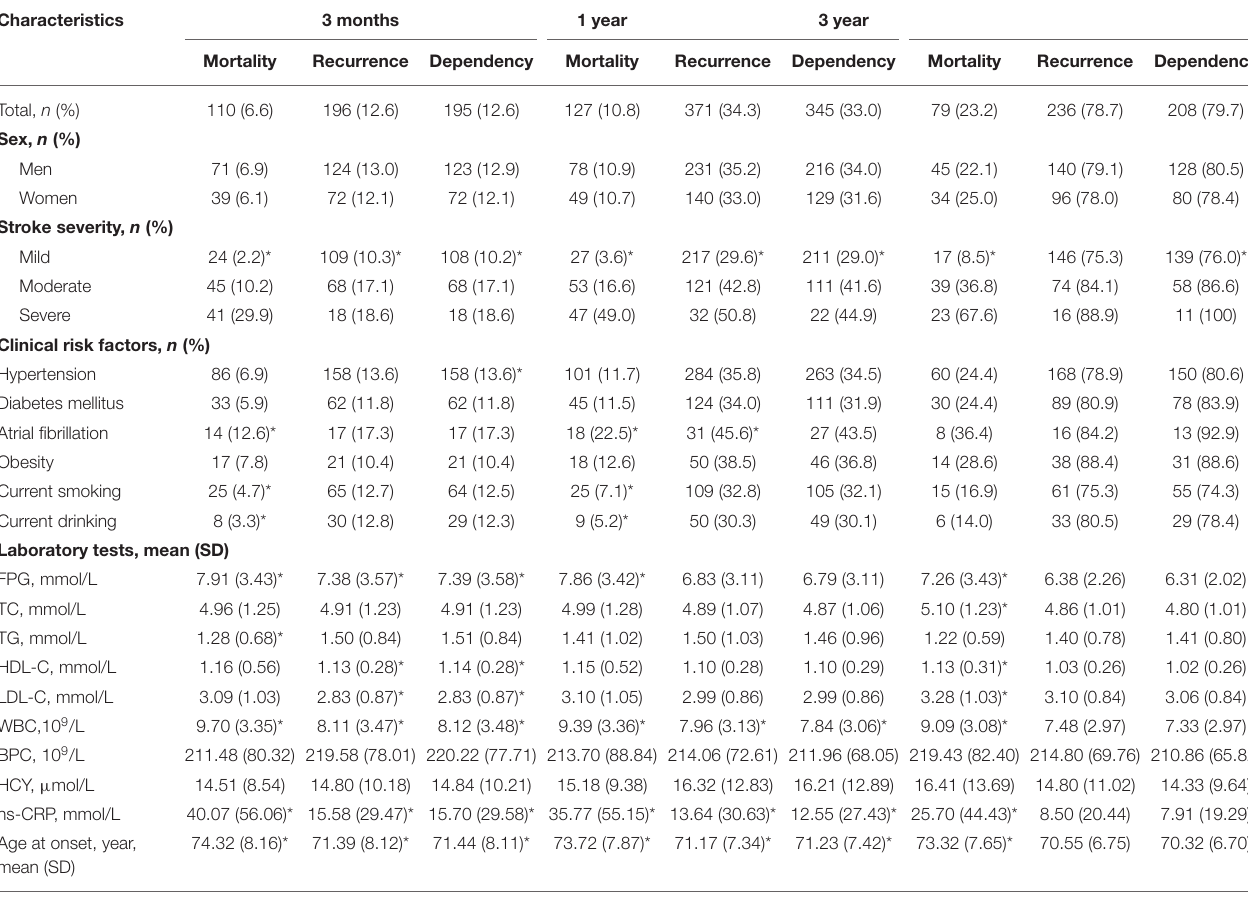
TABLE 2 | Factors associated with outcomes at 3-, 12-, and 36-month after stroke among patients with LAA by univariate analysis.